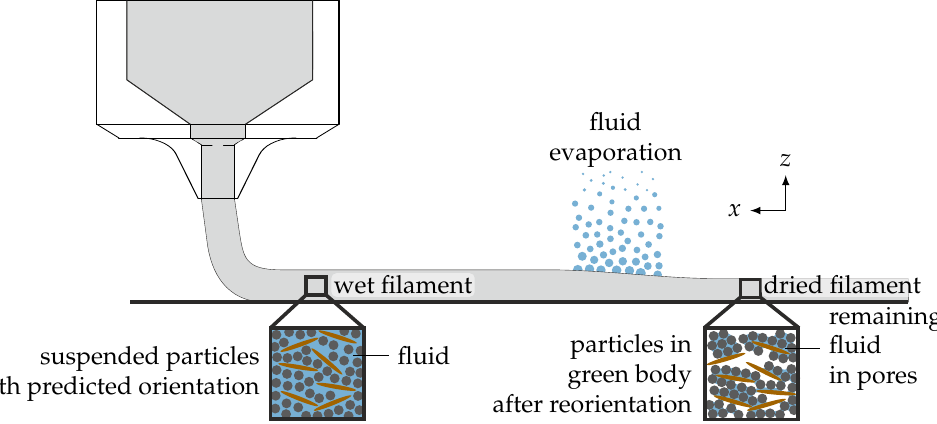
Figure 1. Overview figure of the scope of this work. The figure shows an illustration of the robocasting process that extrudes a ceramic filament. A zoom shows the microstructure in the wet filament that is usually predicted using numerical simulation or analytical models. After printing, the carrier fluid evaporates, during which the particle orientation changes (second microstructure), yielding the microstructure that can be measured in the